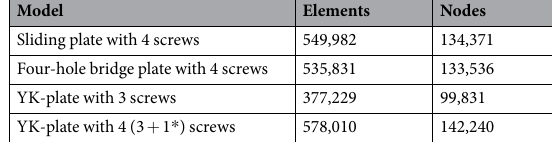
Table 2. Finite element model elements and nodes. * Oversized head